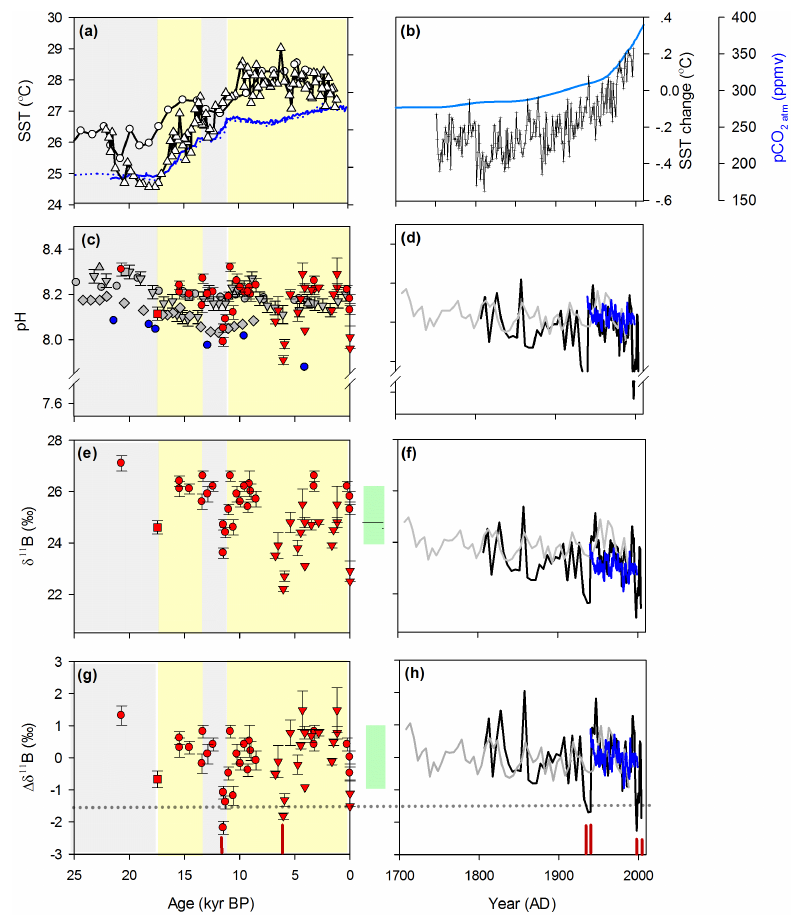
Figure 3. 25000 year records of paleo-ocean climate and pH (a–d) and boron isotopic compositions in coral skeletons (e–h) . Blue lines (a–b) represent atmospheric p CO 2 measured in gas trapped in ice cores (Monnin et al., 2001, 2004; Petit et al., 1999; Robertson et al., 2001) and direct measurements (Tans, 2012), open symbols represent SST records (triangles – South China Sea, Steinke et al., 2008, circles – Western Caribbean sea, Schmidt et al., 2006, and crosses – modern tropics (Indian and Pacific oceans), Wilson et al., 2006). δ 11 B derived pH from foraminifera (ocean surface in gray symbols – circles, Foster, 2008; inverted triangles, Palmer and Pearson, 2003; rectangles, Hönisch et al., 2009; diamonds, Palmer et al., 2010 and triangles, Hönisch and Hemming, 2005; Deep waters pH in blue symbols, Yu et al., 2010) and coral (red symbols – circles, Douville et al., 2010, inverted triangles, Liu et al., 2009 and rectangles, Gaillardet and Allegre, 1995; grey, Pelejero et al., 2005 blue, Shinjo et al., 2013 and black, Wei et al., 2009 lines) is shown in (c–d) . The boron isotopic compositions, on which coral pH is based, are presented in (e–f) . The difference of δ 11 B from the average value in record ( (cid:49)δ 11 B) is shown in (g–h) together with a dotted line under which data points are suggested to represent coral bleaching. Green bars and line within represent δ 11 B annual range and average measured at unbleached coral (Hemming et al., 1998). Red vertical lines mark the timing of suspected bleaching events. Grey and yellow shaded bars represent cold and warm periods,